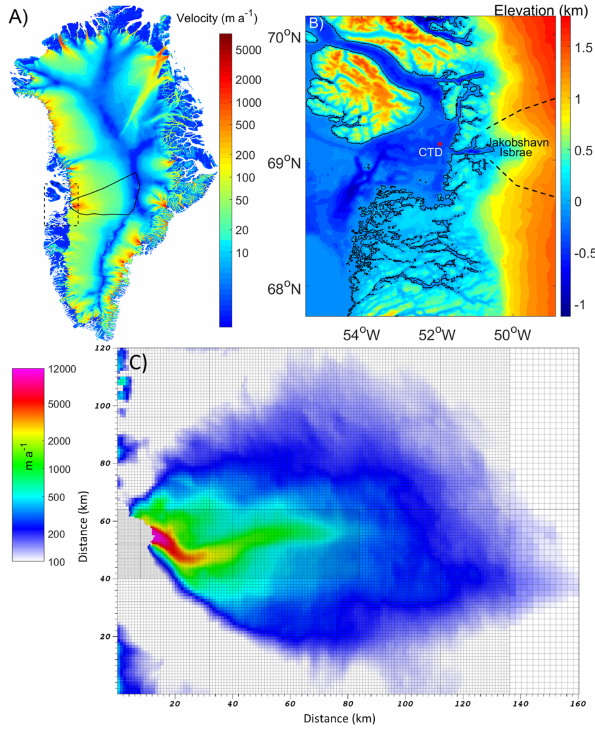
Figure 1. (a) Greenland ice sheet flow speeds from Joughin et al. (2018), with the Jakobshavn drainage basin outlined by the solid black line and the area shown in (b) by the dashed box. (b) Ilulissat Fjord and Disko Bay bathymetry from Jakobsson et al. (2012), with the CTD (conductivity temperature depth) site used for ocean tem- perature marked by the red star. (c) Example of the mesh used with finest resolution of 500m with modeled velocities at the beginning of